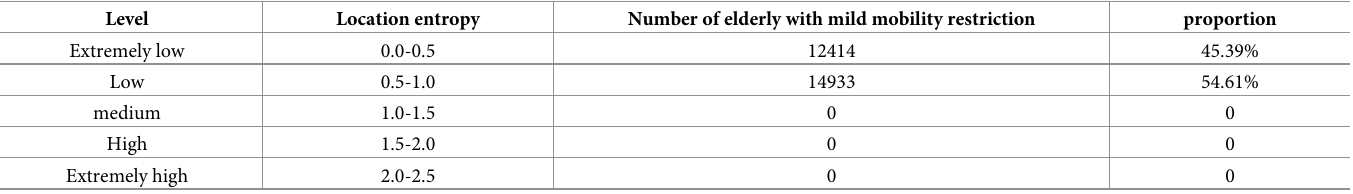
Table 7. Statistics on the number and proportion of the elderly with mild mobility restriction in the entropy sub-grade of the community home care facility area.